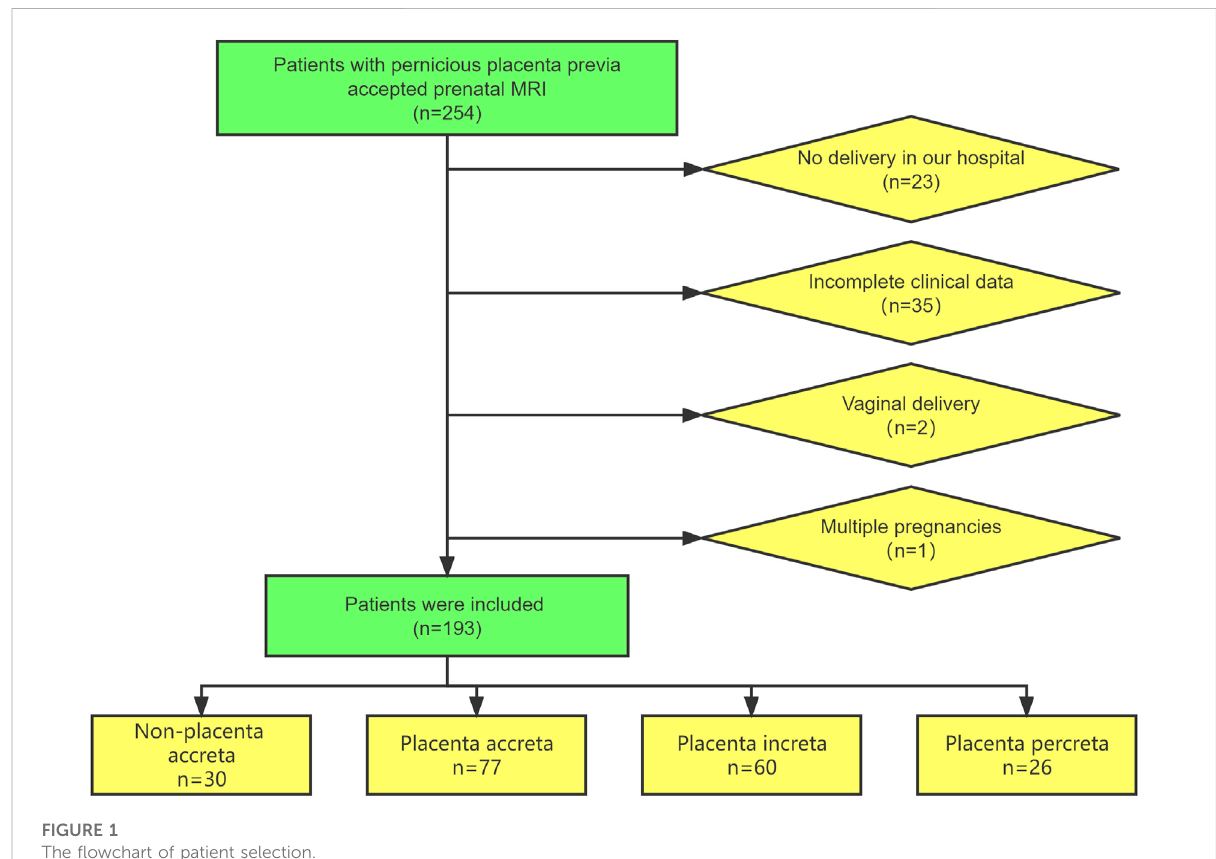
FIGURE 1 The fl owchart of patient